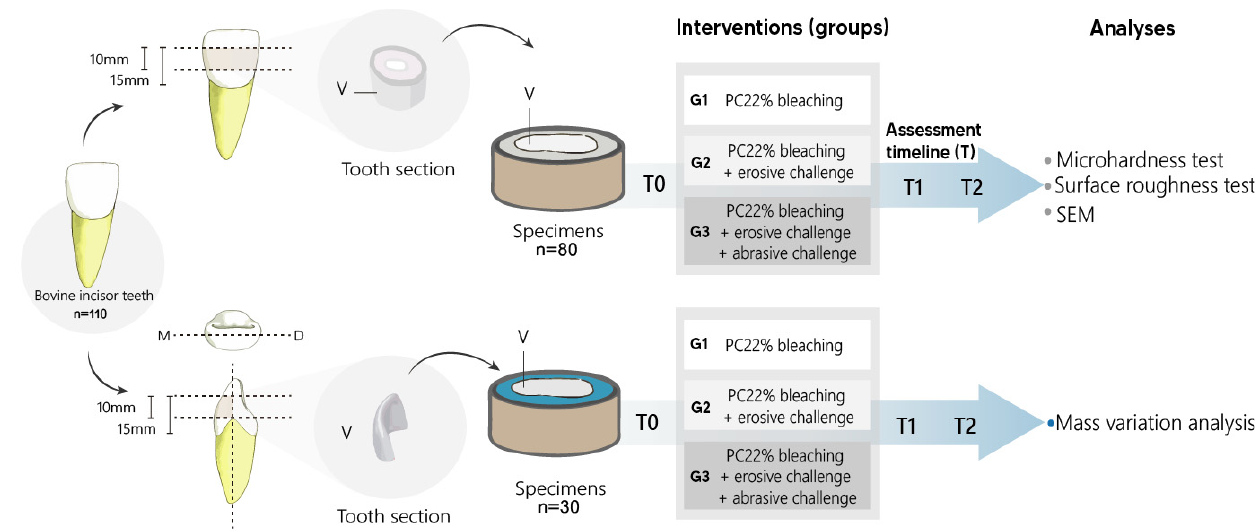
Figure 1. The preparation of specimens and group division. Table 1. The description of materials used including their trade names and